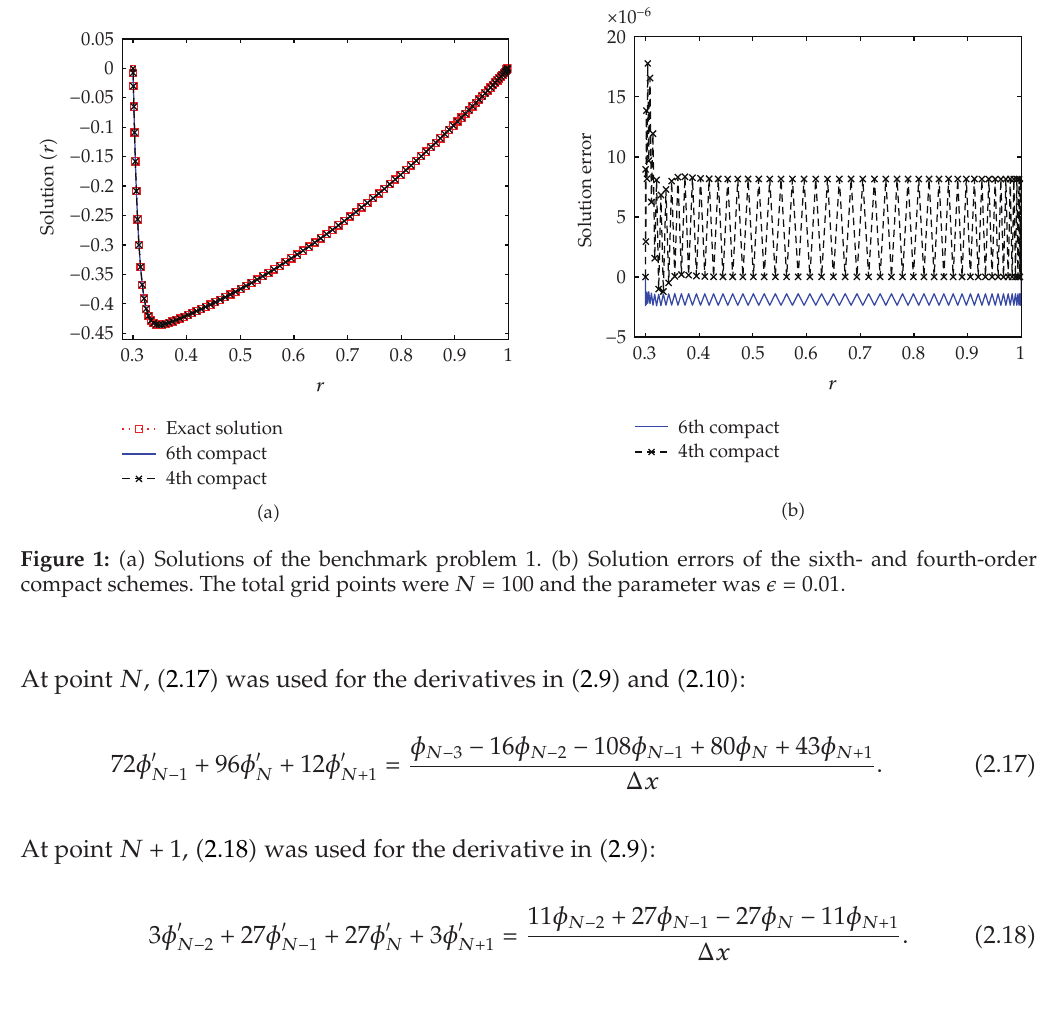
Figure 1 (cid:6) a (cid:7) shows three sets of solutions: the exact solution and the approximate solutions from the sixth- and fourth-order compact schemes. No visible di ff erence is observed at this scale. On the left is a thin boundary layer with a velocity gradient about two orders of magnitude larger than the solution itself. On the right is a laminar boundary layer with a mild velocity gradient. Figure 1 (cid:6) b (cid:7) presents the solution errors (cid:6) exact solution-approximate solution (cid:7) in the sixth- and fourth-order compact schemes. Even though there is a large velocity gradient inside the thin boundary layer at the left end, both schemes are able to capture the characteristics of the boundary layer, with the error in the sixth-order scheme reduced to about 1 / 6 of that in the fourth-order